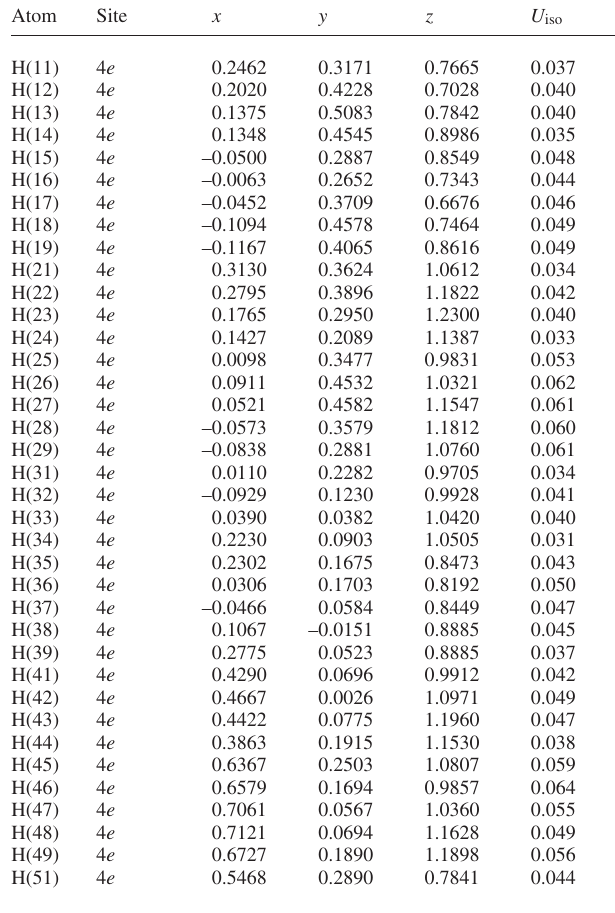
Table 2. Atomic coordinates and displacement parameters (in Å 2 )